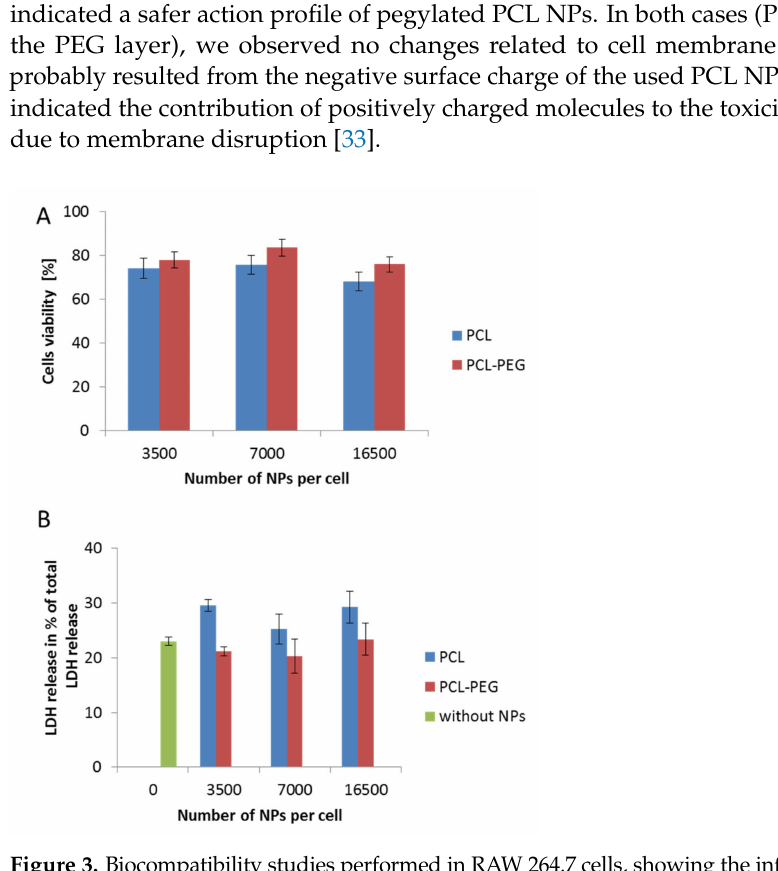
Figure 3. Biocompatibility studies performed in RAW 264.7 cells, showing the influence on cell stability of various types of synthesized PCL NPs used in different doses. ( A ) MTT cell viability assay after a 24 h incubation period with NPs. ( B ) Cytotoxicity assay showing LDH (Lactic Dehydrogenase) release (over a 4 h incubation period with NPs). Data represent the ± standard error of the mean